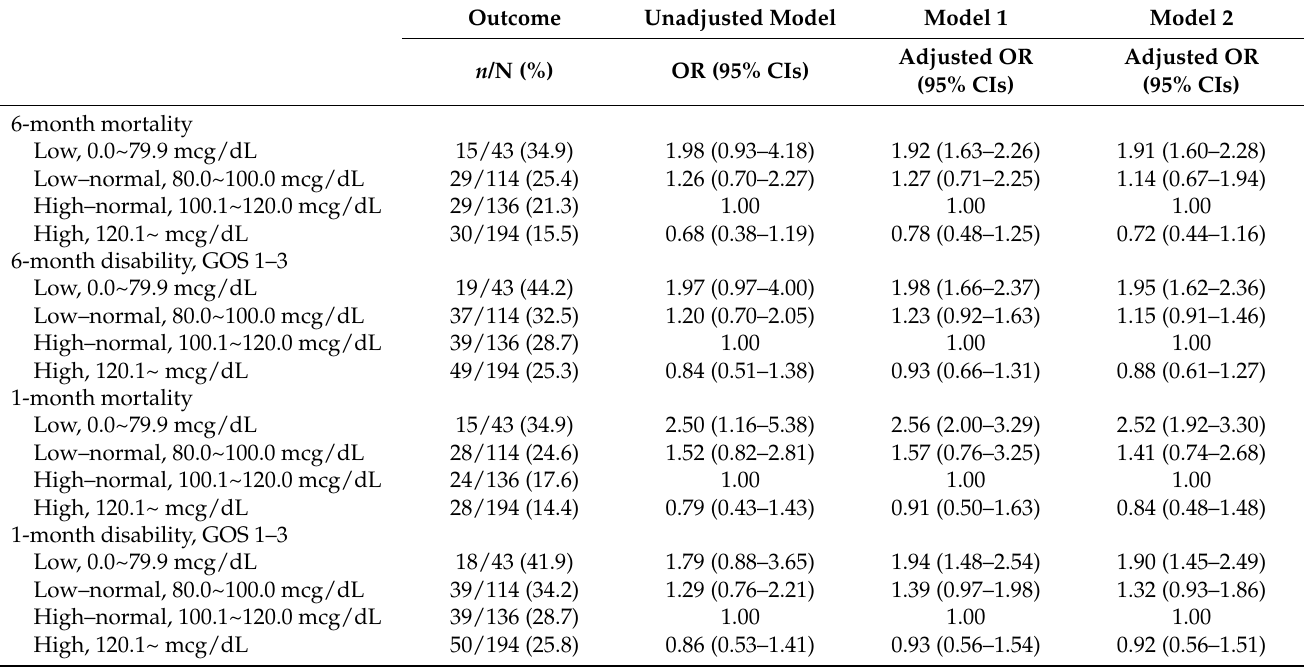
Table 2. Multilevel logistic regression analysis for study outcomes according to serum zinc levels.